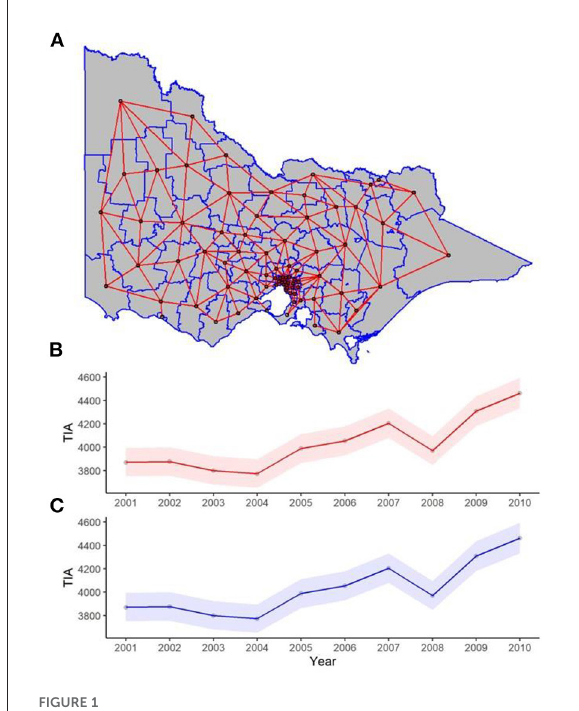
FIGURE1 (A) Spatial and (B,C) temporal weights for spatial and spatiotemporal regression. (A) Each red line in the map of the state represents two neighboring LGAs (where two regions share one point in common boundary), and this was used for the spatial weight component of the spatiotemporal regression. The red and blue trend lines of TIAs per year are the posterior distribution of the temporal weights of the (B) spatial lag, and (C) Leroux models respectively used in the spatiotemporal regression, with 95% confidence interval